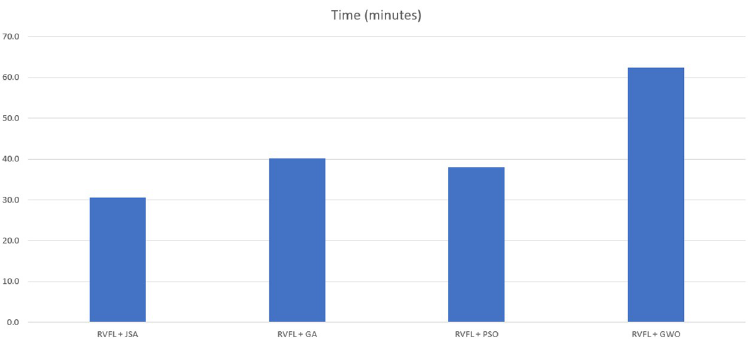
Fig 8. Time in minutes for each algorithm’s execution